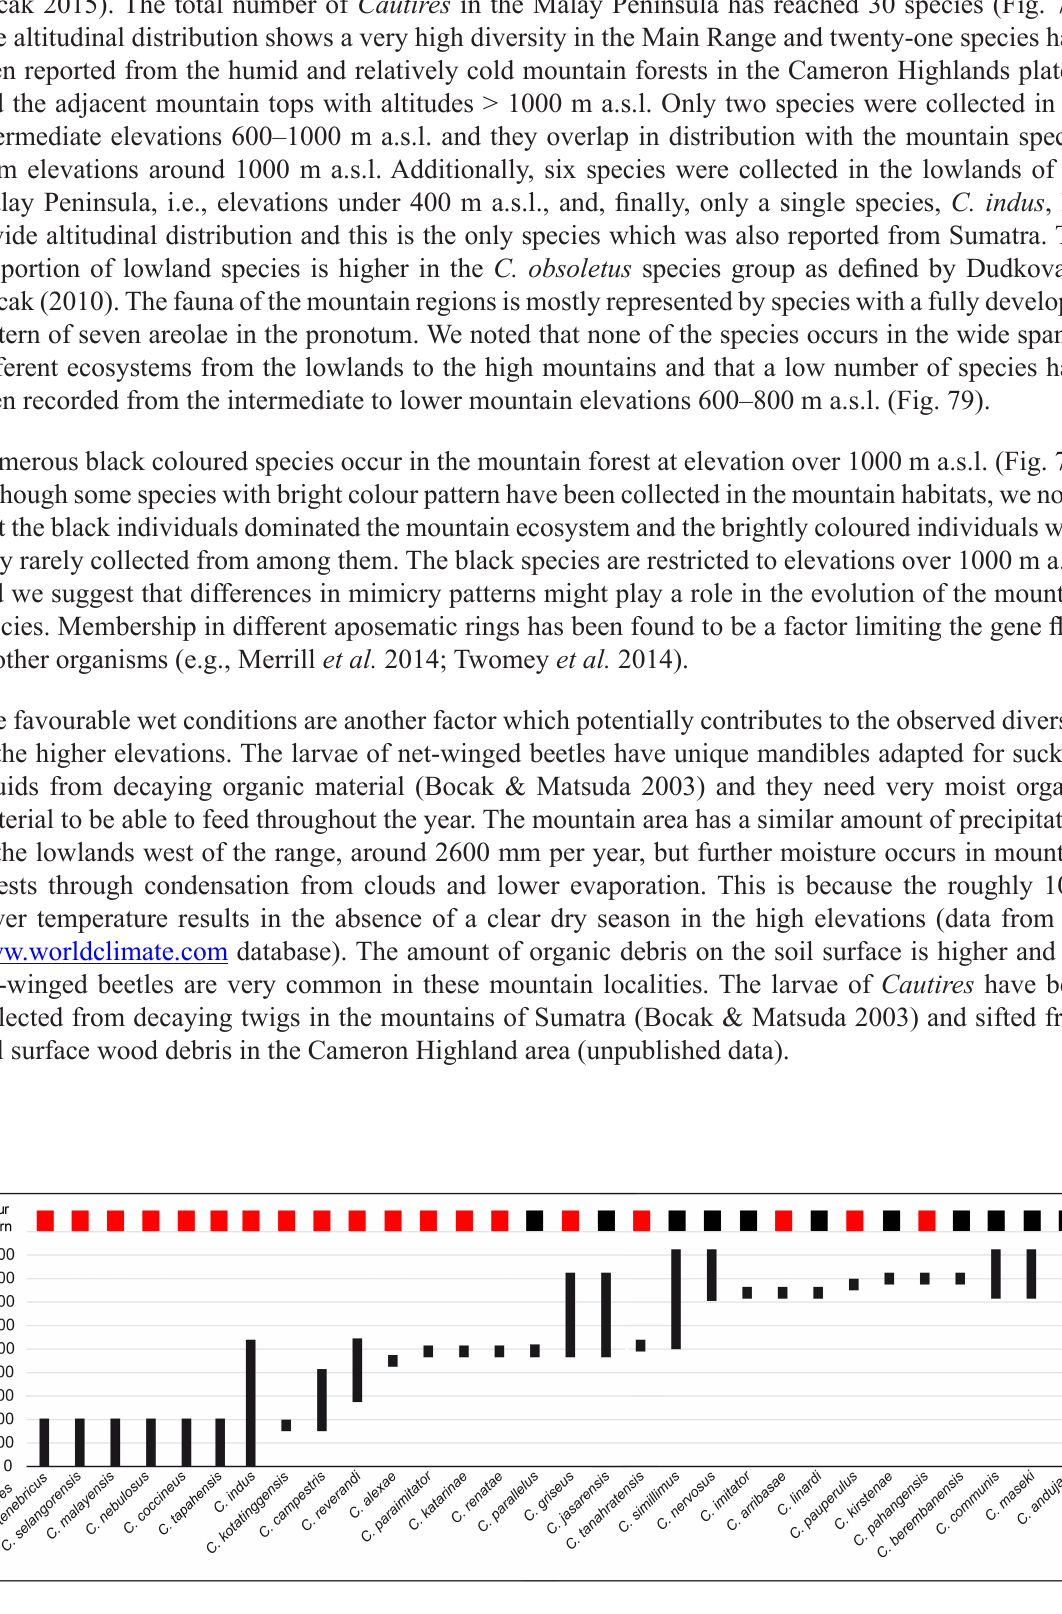
Fig. 79. the altitudinal zonation of the Cautires species occurring in the Malay